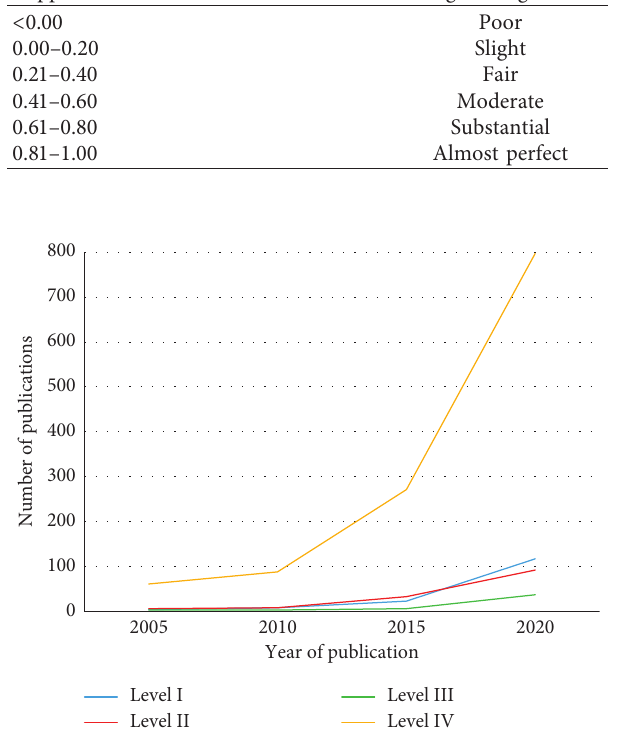
Figure 2: Saudi dental publication pattern based on a modified Oxford level of evidence